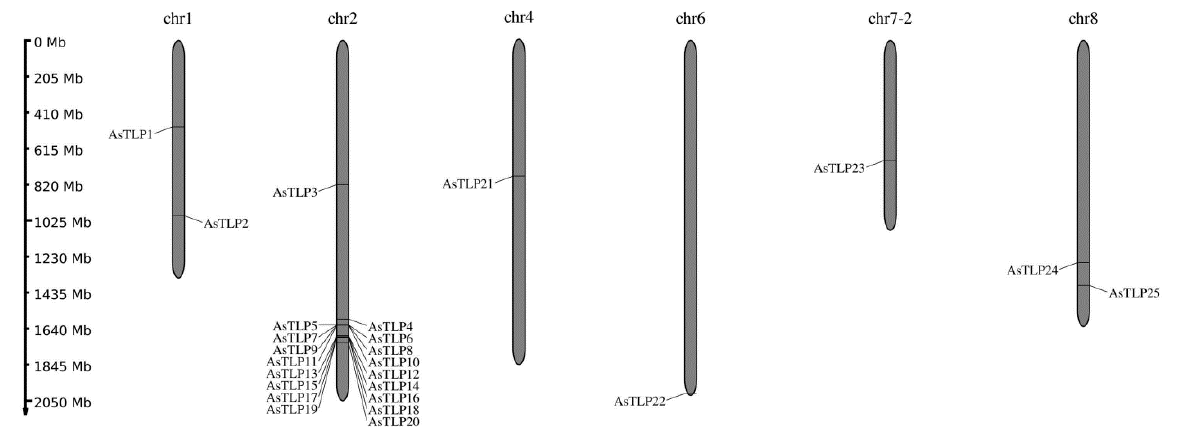
Figure 1. Locations of AsTLP genes in the A. sativum chromosomes. Chromosome lengths (indicated on the left) are based on the A. sativum cv. Ershuizao genome (PRJNA606385; assembly Garlic.V2.fa); chr, chromosome.